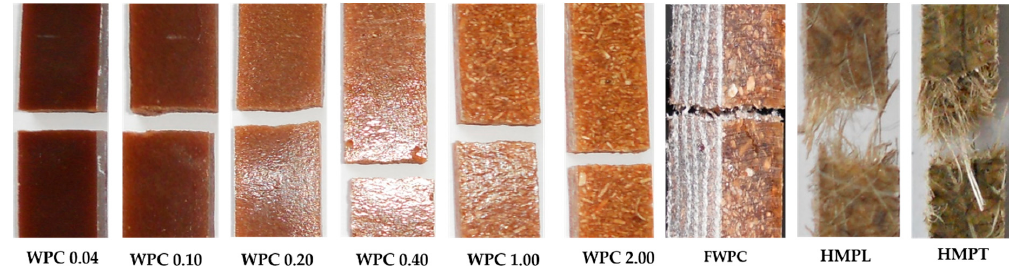
Figure 15. Modes of fractures recorded for all natural tested fibre reinforced composites.